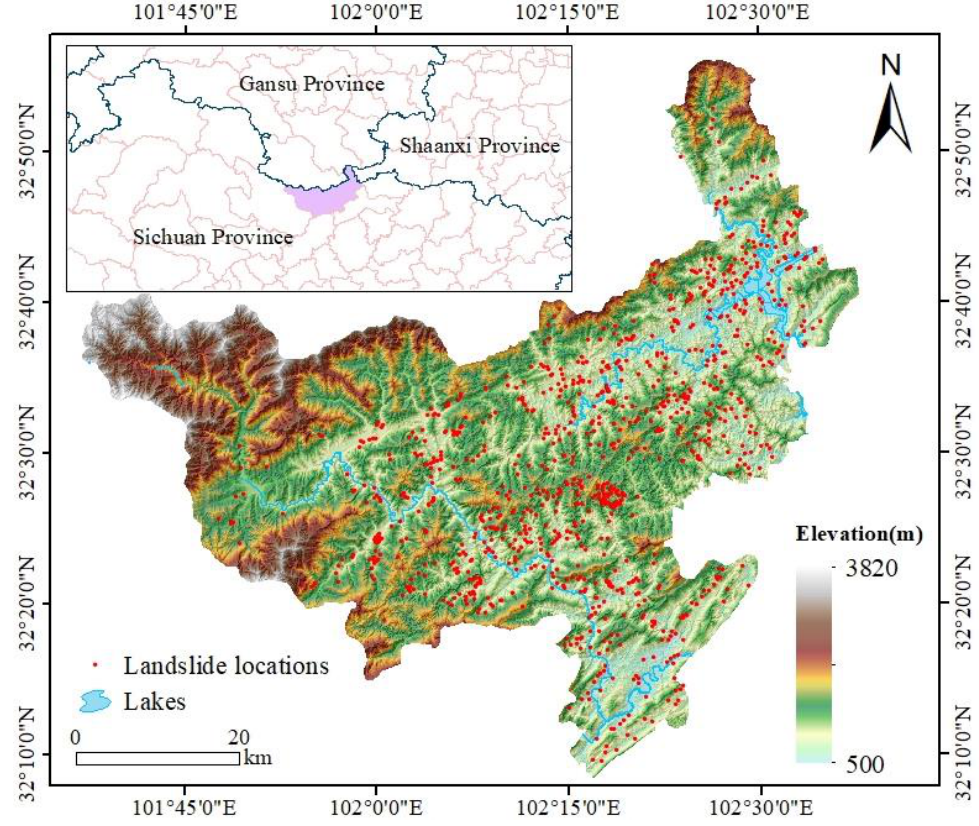
Figure 1. Landslide inventory map and location of Qingchuan County.